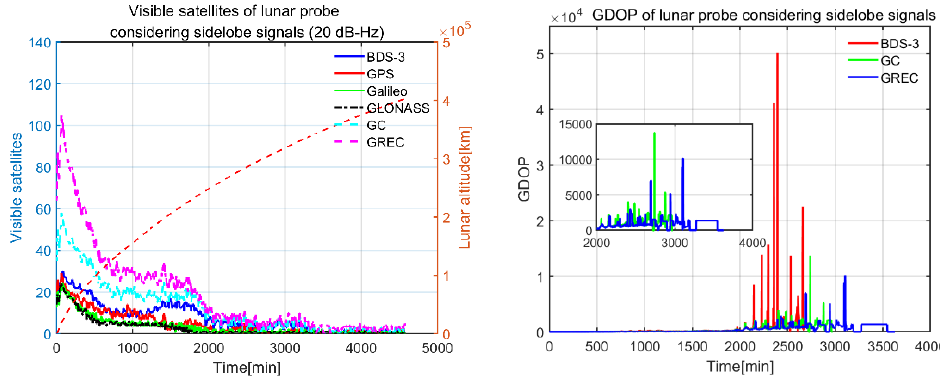
Figure 14. Visible satellites and GDOP of lunar probe with 20 dB-Hz threshold.